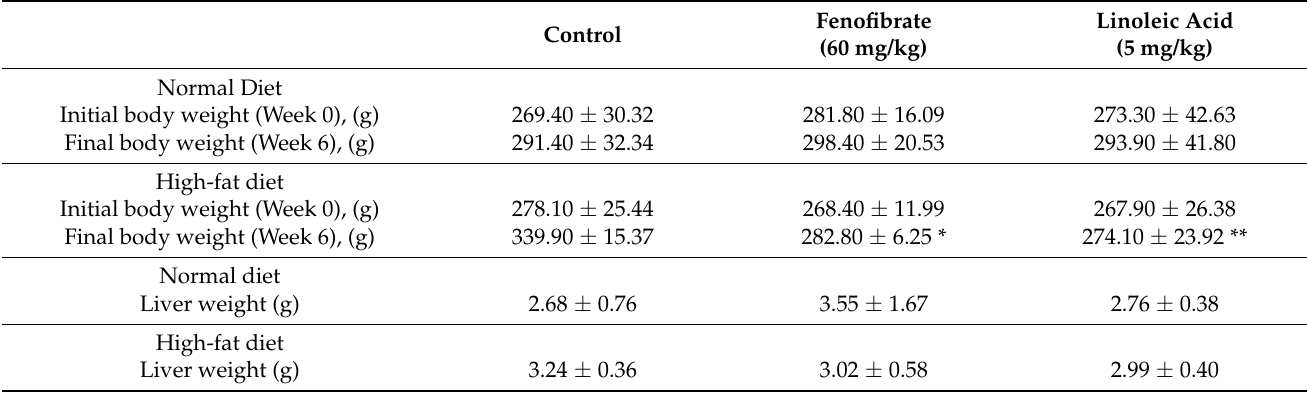
Table 2. Body weight and liver weight of rats fed with a normal diet and a high-fat